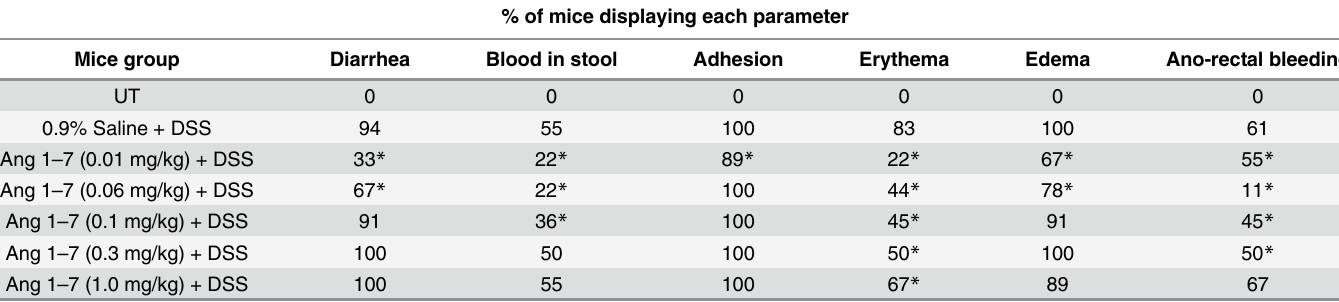
Table 1. Effect of Ang1-7 on macroscopic features of colitis when administered simultaneously with DSS. % of mice displaying each parameter Mice group Diarrhea Blood in stool Adhesion Erythema Edema Ano-rectal bleeding